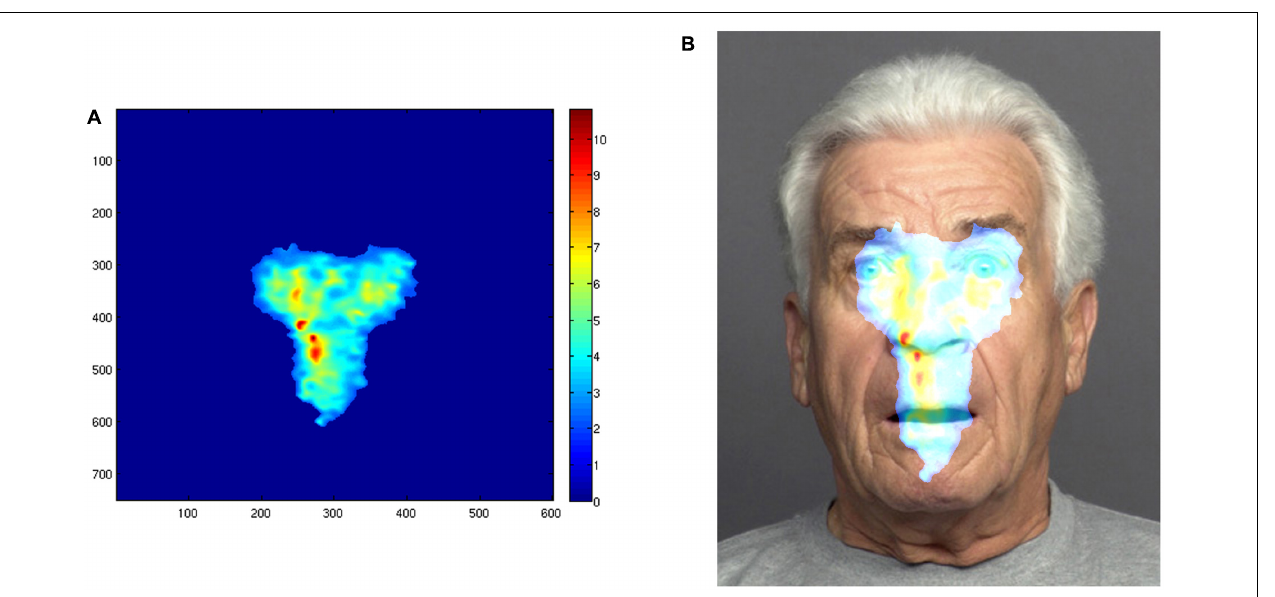
FIGURE 3 | Pixel-wise statistical map showing the number of fixations in the stimulus space of the deliberate group as revealed by the i Map3 analysis. (A) The statistical pattern of distribution of fixations. The colors of the map correspond to fixation counts on that particular area (see color scale on the right). (B) The same pattern mapped onto an example stimulus. A one-tailed Pixel test (Chauvin et al., 2005) was applied for the group fixation maps ( p < 1,0). Finally, for each condition average Z -score values were extracted for each observer individually, within the regions showing significance in the differential fixation